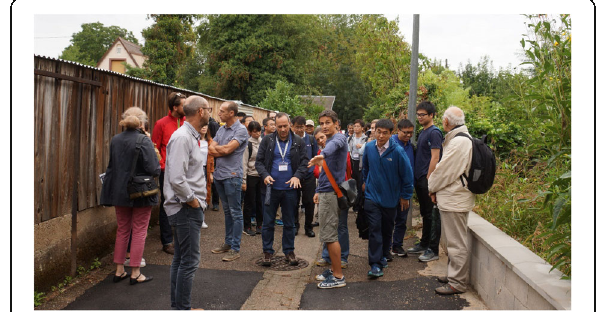
Fig. 6 Finding the mudflow direction in the field